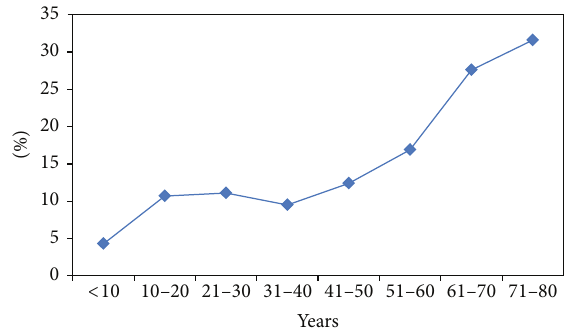
Figure 3: Mortality among TBI patients according to age ( 𝑃 = 0.001 ).